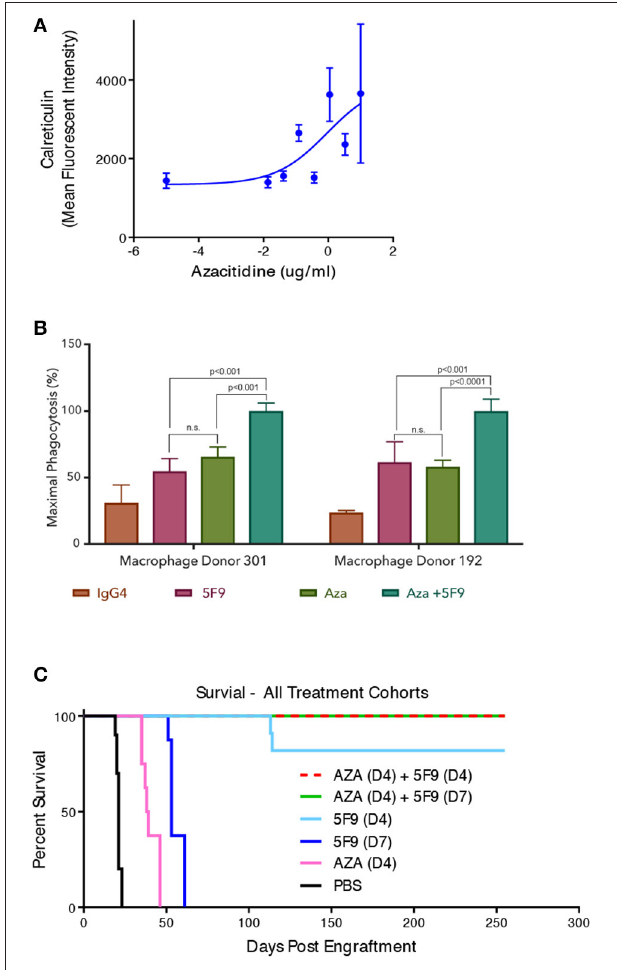
FIGURE 2 | Magrolimab combination with azacitidine enhances therapeutic phagocytosis and pre-clinical efficacy in AML. (A) Calreticulin cell surface binding sites were assessed by flow cytometry on HL60 AML cells in the presence of increasing concentrations of azacitidine that are comparable